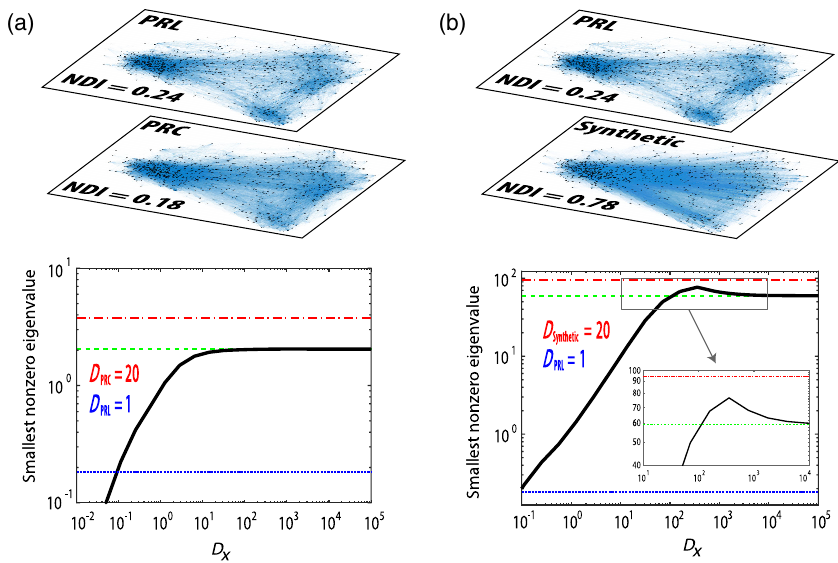
FIG. 4. Author-citation multiplex. (a) The top panel shows the author-citation network extracted from articles published in PRL (upper layer) and PRC (lower layer). No prime regime is observed for any combination of the parameters [ D , D , D X ]. The bottom panel PRL PRC ; D 1 ; 20 (cid:2) as an example. (b) The top panel shows the author-citation shows the behavior of Re ð Λ 2 Þ as a function of D X for ½ D PRL PRC (cid:2) ¼ ½ network extracted from articles published in PRL (upper layer) and a synthetic citation network created with the same number of nodes and same out-degree distribution with the one obtained from PRC but with a higher value of the NDI (lower layer). The sufficient network-scale directionality that characterizes the bottom layer is able to induce the prime regime as shown in the bottom